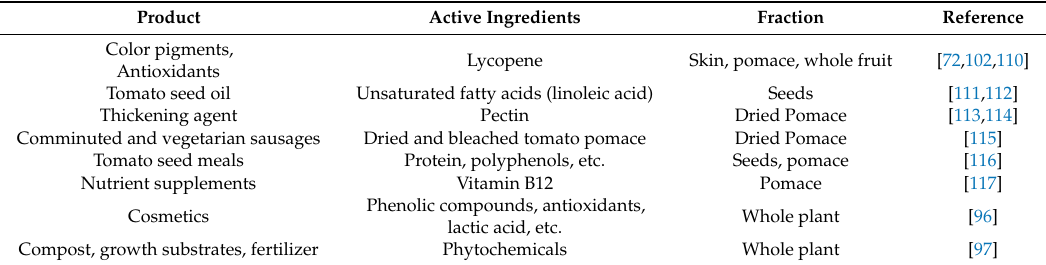
Table 6. Proposed utilization of tomato side streams and by-products from food processing.